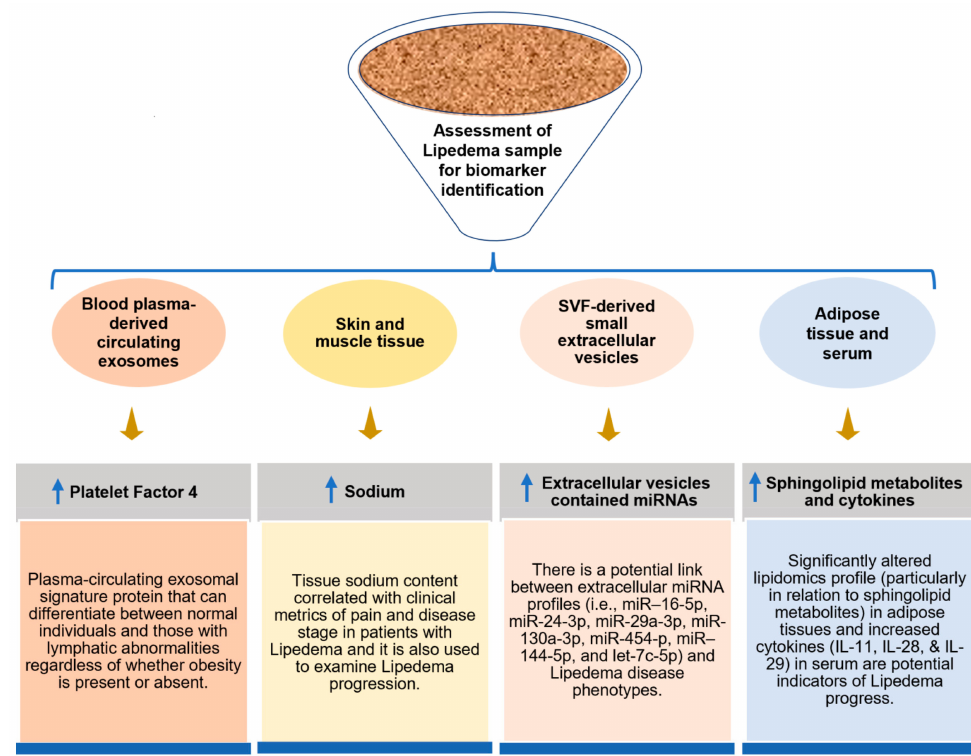
Figure 4. Schematic representation of identified lipedema biomarkers. This image shows the findings of some promising biomarkers from various sources of the lipedema samples and the underlying investigation to find their potential as diagnostic tools for